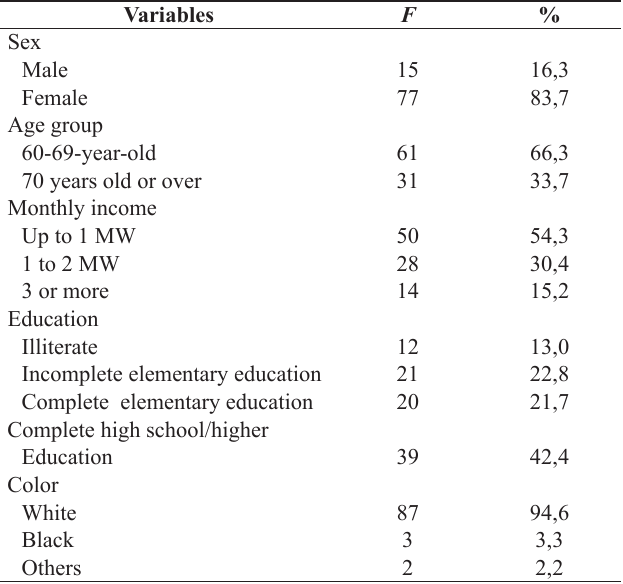
Table 1. Absolute and relative frequencies of the sociodemograph- ic profile of the elderly who practice physical exercises. Maringá, Paraná, Brazil, 2018.